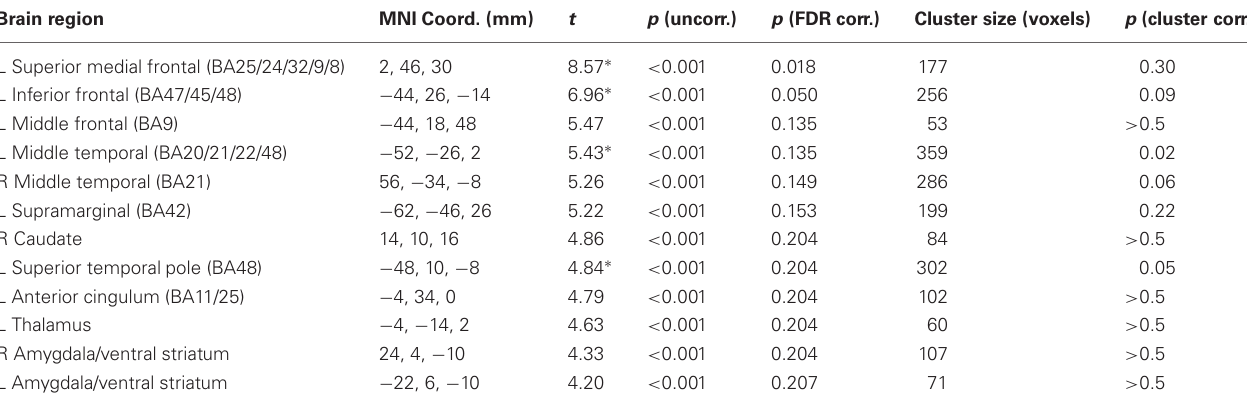
Table 5 | High vs. low emotion, whole brain